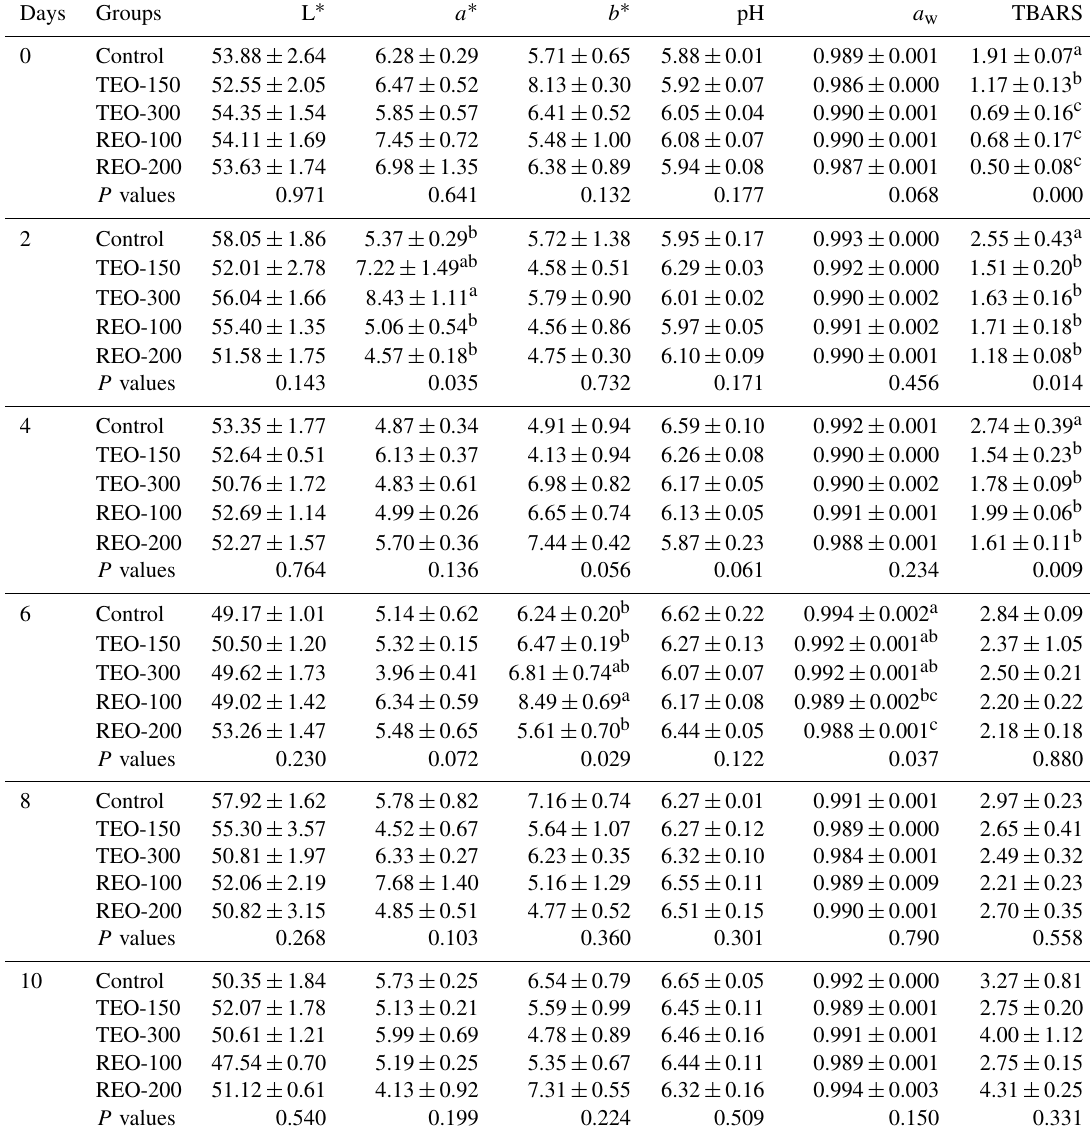
Table 6. Effects of dietary thyme and rosemary essential oils supplementation and storage period on colour parameters (L ∗ , a ∗ and b ∗ ), water activity ( a w ), pH and TBARS in chicken drumstick